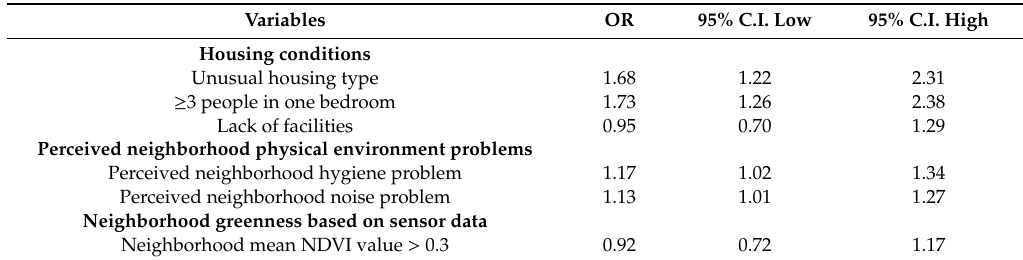
Table 4. Fully adjusted odds ratios (ORs) of housing conditions and neighborhood physical environments on SHS exposure at home among non-smoking migrant workers with the neighborhood physical environment scan statistics excluded. C.I.: confidence interval. NDVI: Normalized Di ff erence Vegetation Index. Variables